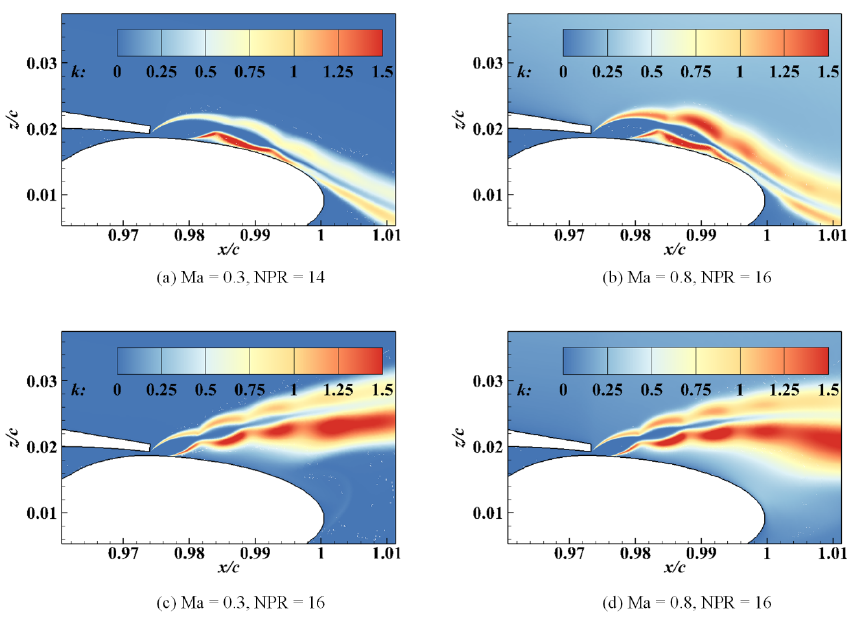
Figure 16. Growth of the jet shear layers based on k × 10,000.